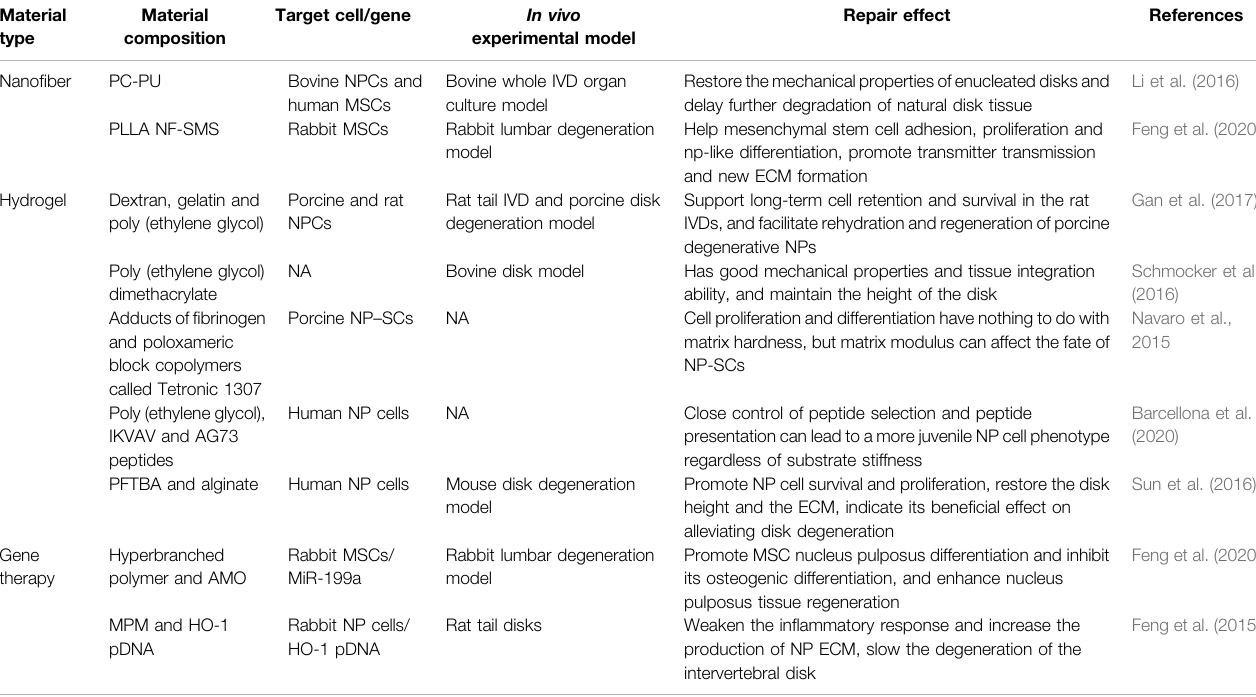
TABLE 1 | Summary of various biomaterials for nucleus pulposus repair and their